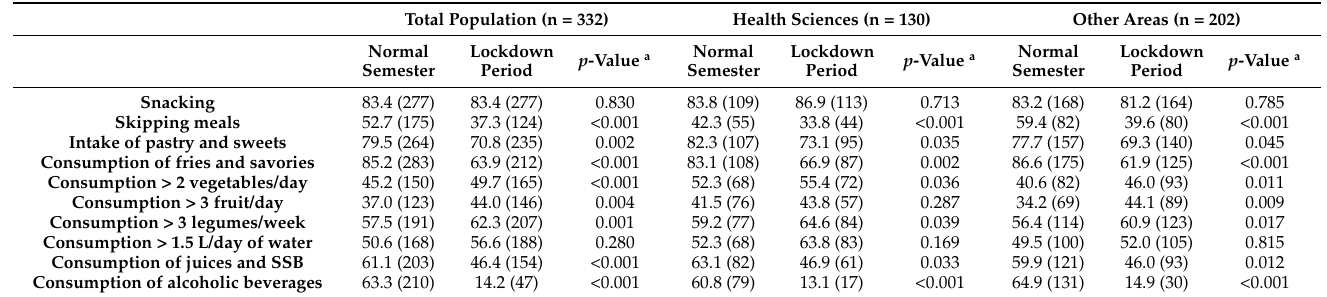
Table 2. Self-reported food intake and eating habits between the normal semester and the lockdown period due to the COVID-19 pandemic, according to the area of study. Total Population (n = 332) Health Sciences (n = 130) Other Areas (n = 202) Normal Lockdown Lockdown Lockdown p -Value a Normal p -Value a Normal p -Value a Semester Period Semester Period Semester Period